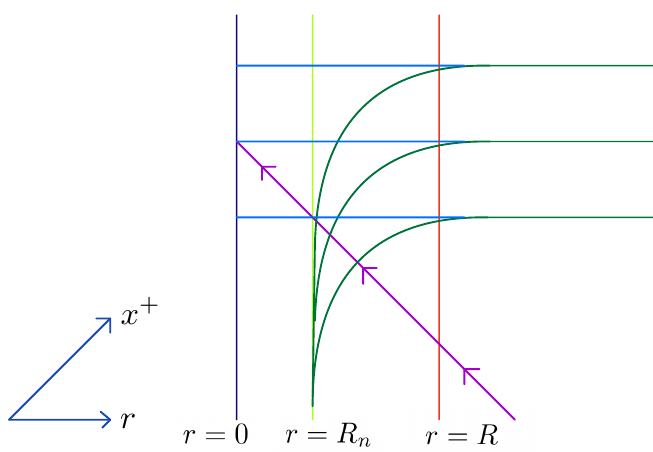
Figure 4 . Slices in a four (or higher) dimensional Schwarzschild BH spacetime. Straight slices end at r = 0 , and so do not provide good Cauchy slices; for example, data corresponding to the infalling excitation shown does not register on later straight slices, unless additional degrees of freedom are included “at r = 0 ”. Slices that have nice behavior, in that they avoid the singularity, as shown, do in contrast provide Cauchy